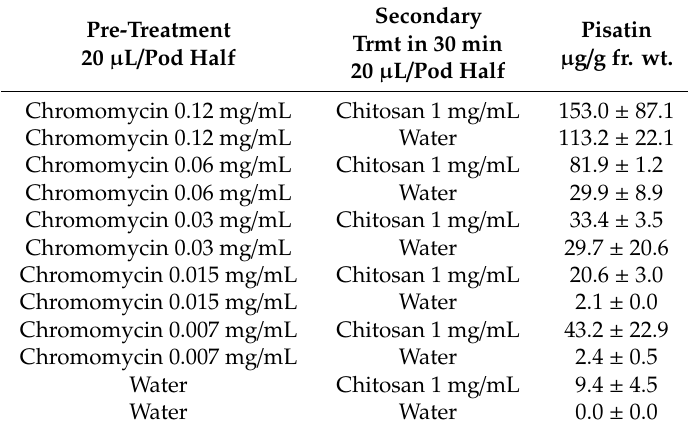
Table 6. The combined action of chromomycin and chitosan in elicitation of pisatin production. Pea endocarp halves received 20 µ L volume of all treatments as indicated and pisatin was quantified as